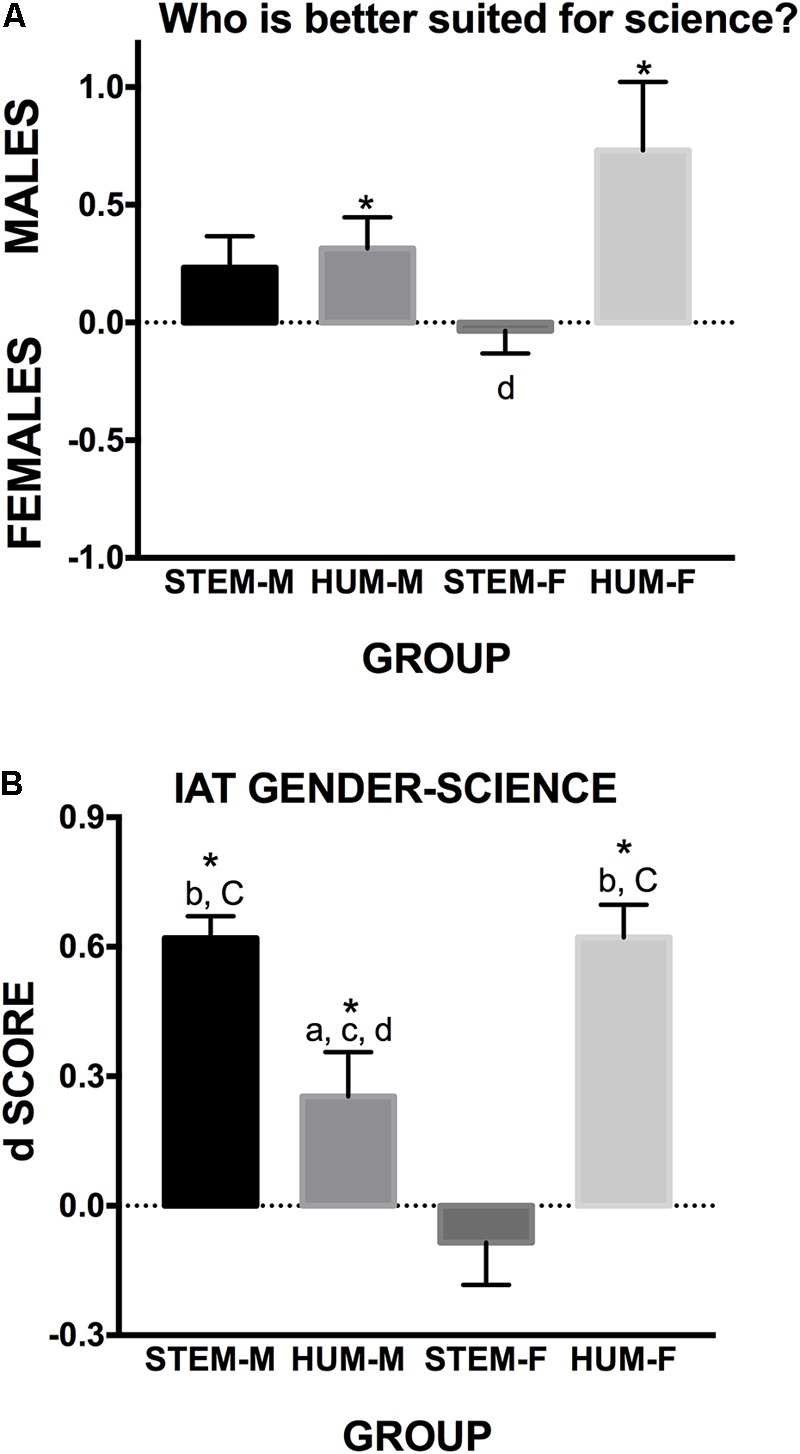
Explicit beliefs and implicit associations. (A) Depicts explicit beliefs as to a different suitability of males and females for science studies/professions. (B) Illustrates the d-scores for IAT Gender-Science. ∗Significantly different from zero, p < 0.05; letters denote statistically significant differences between groups: A different from STEM-Males, B different from HUM-Males, C different from STEM-Females and D different from HUM-Females (capital letters, p < 0.01; lowercase letters, p < 0.05).